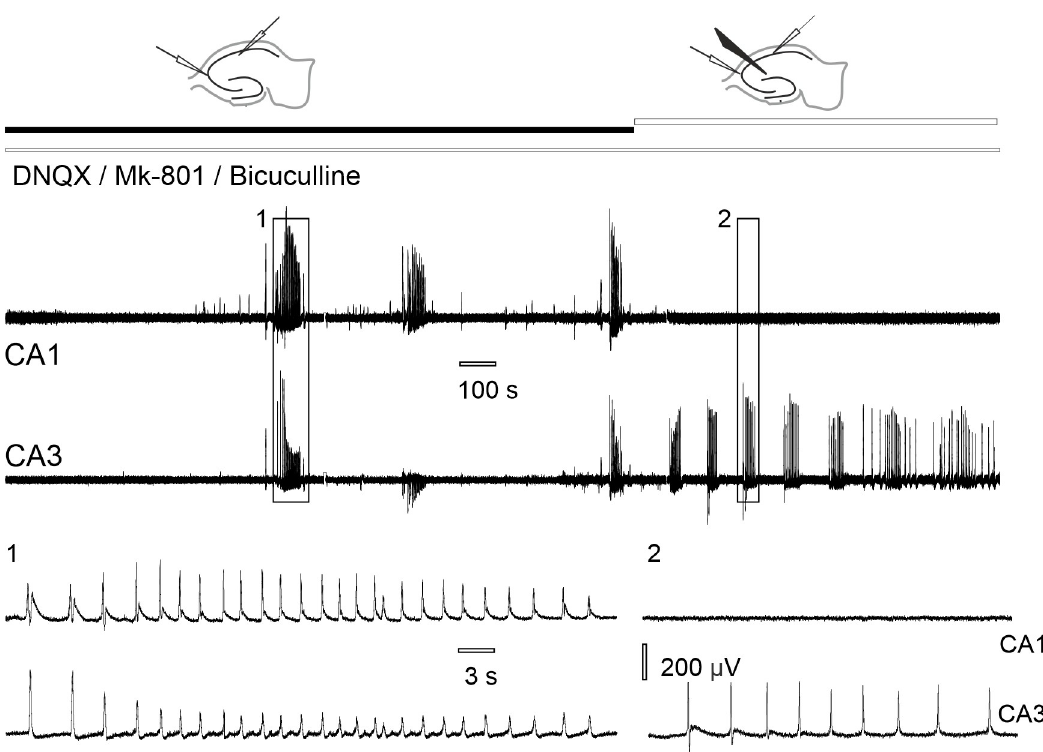
Fig 3. Effect of mechanical separation of CA3 and CA1 hippocampal zones on epileptiform discharges in synaptic blockers aCSF. (1) Burst of discharges synchronized between CA3-CA1. (2) Epileptiform discharges disappear in CA1, but not in CA3 after the separation was made between two recording